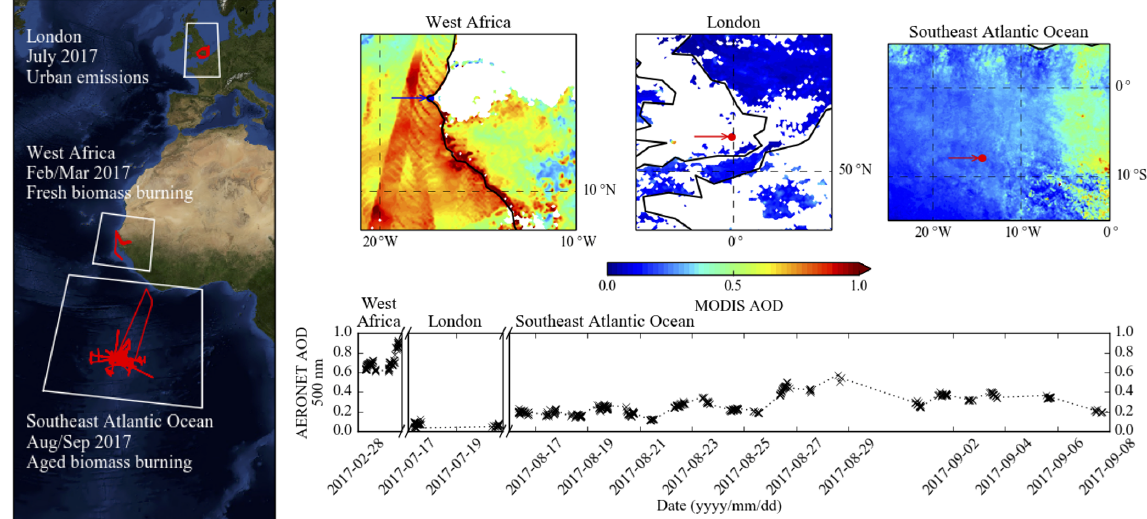
Figure 2. FAAM research aircraft flight tracks (red) over London in the United Kingdom (July 2017), West Africa (February and March 2017) and the Southeast Atlantic (August and September 2017). For each of the geographical areas highlighted in the white boxes, the mean aerosol optical depths (AODs) measured using the Moderate Resolution Imaging Spectroradiometer (MODIS) satellite instruments are displayed. A time series of Aerosol Robotic Network (AERONET) data shows AODs at 500nm corresponding to each measurement period. Note the discontinuous AERONET AOD time axis. AERONET sites are shown on the MODIS AOD plots by